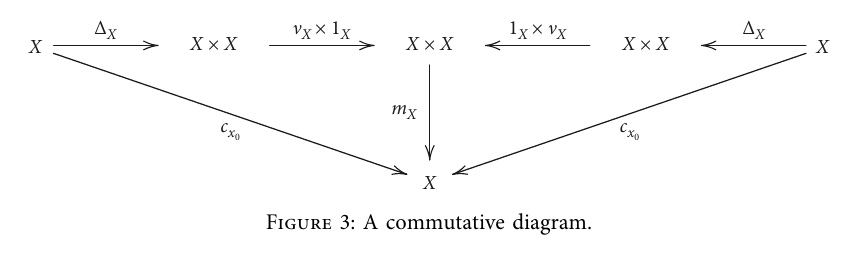
Figure 3: A commutative